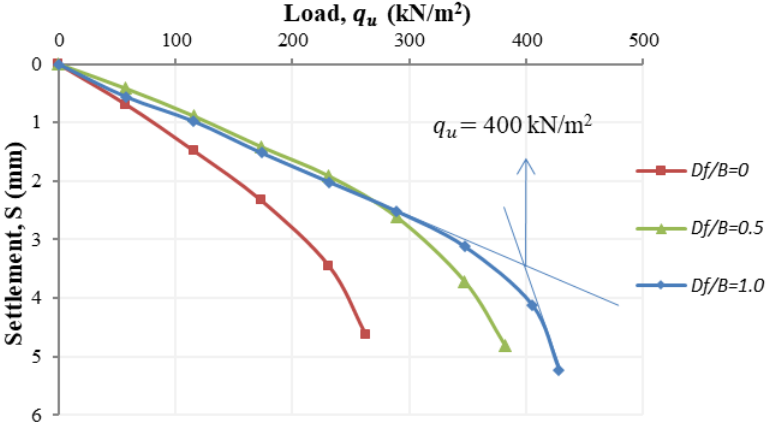
Figure 5: Variation of L–S curve for D